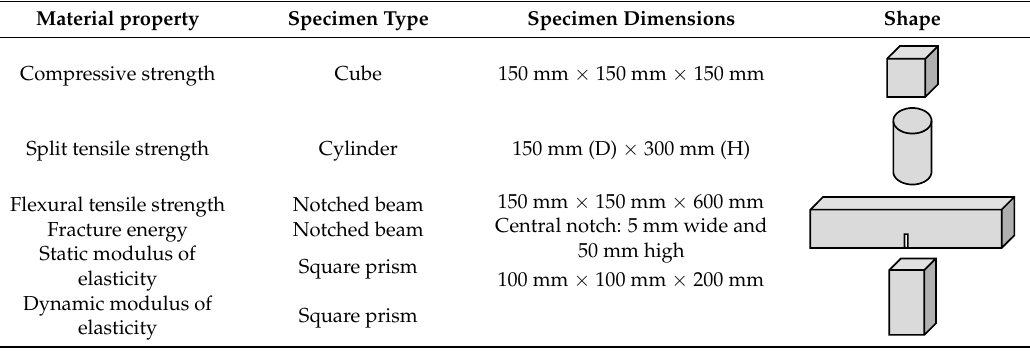
Table 2. Description of the test specimen used to determine material properties.